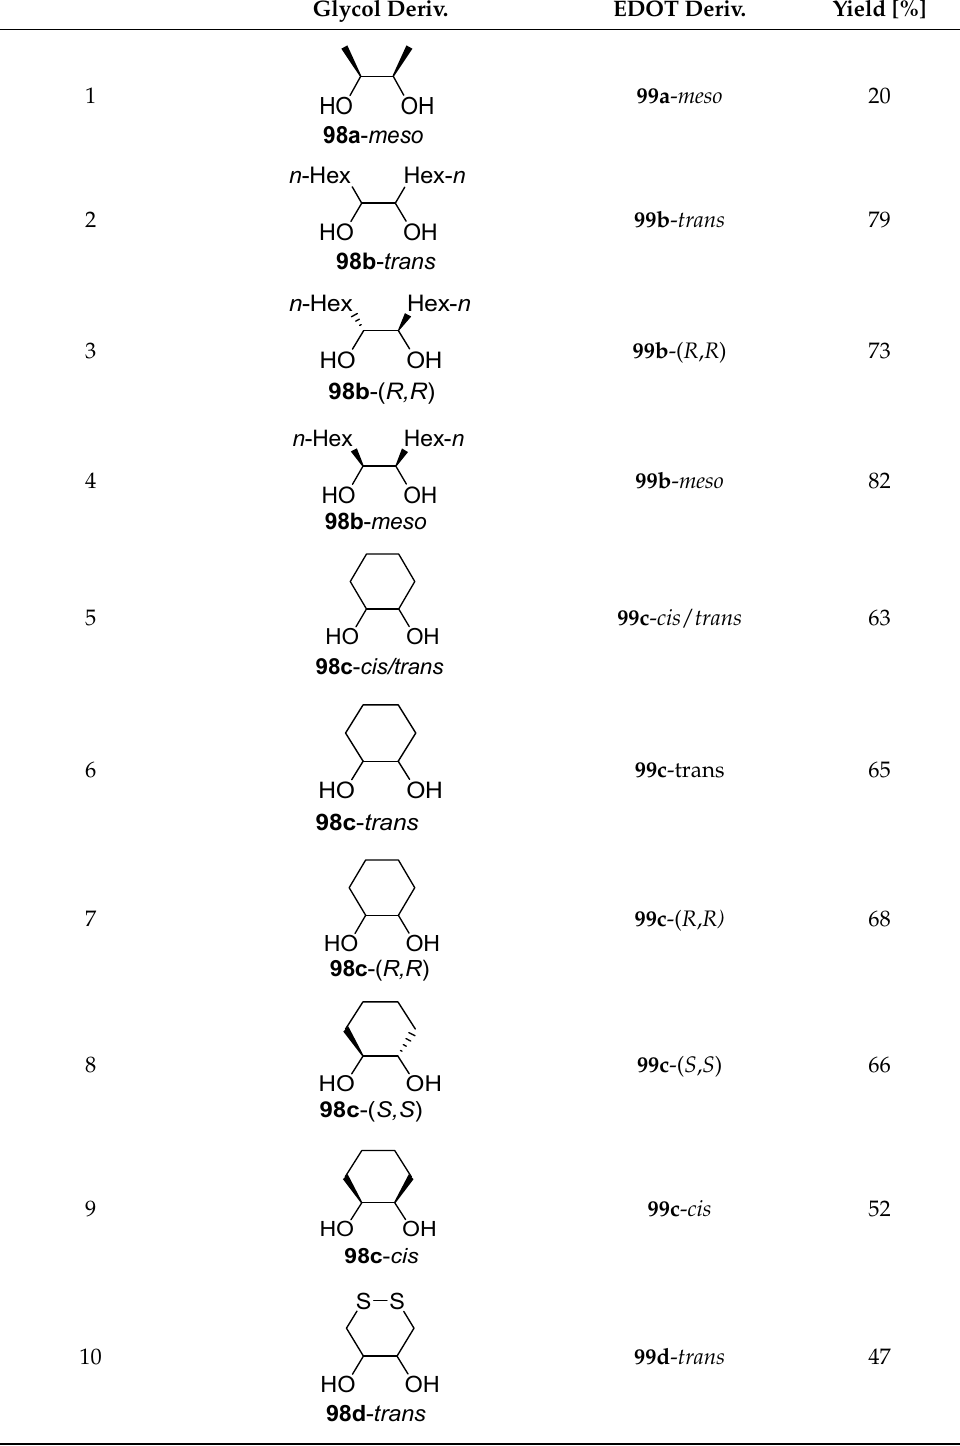
Table 1. Transetherification reaction of 3,4-dimethoxythiophene 97 and (chiral) diols 98a – d to (enan- tiomerically pure) disubstituted EDOTs 99a – d . Glycol Deriv. EDOT